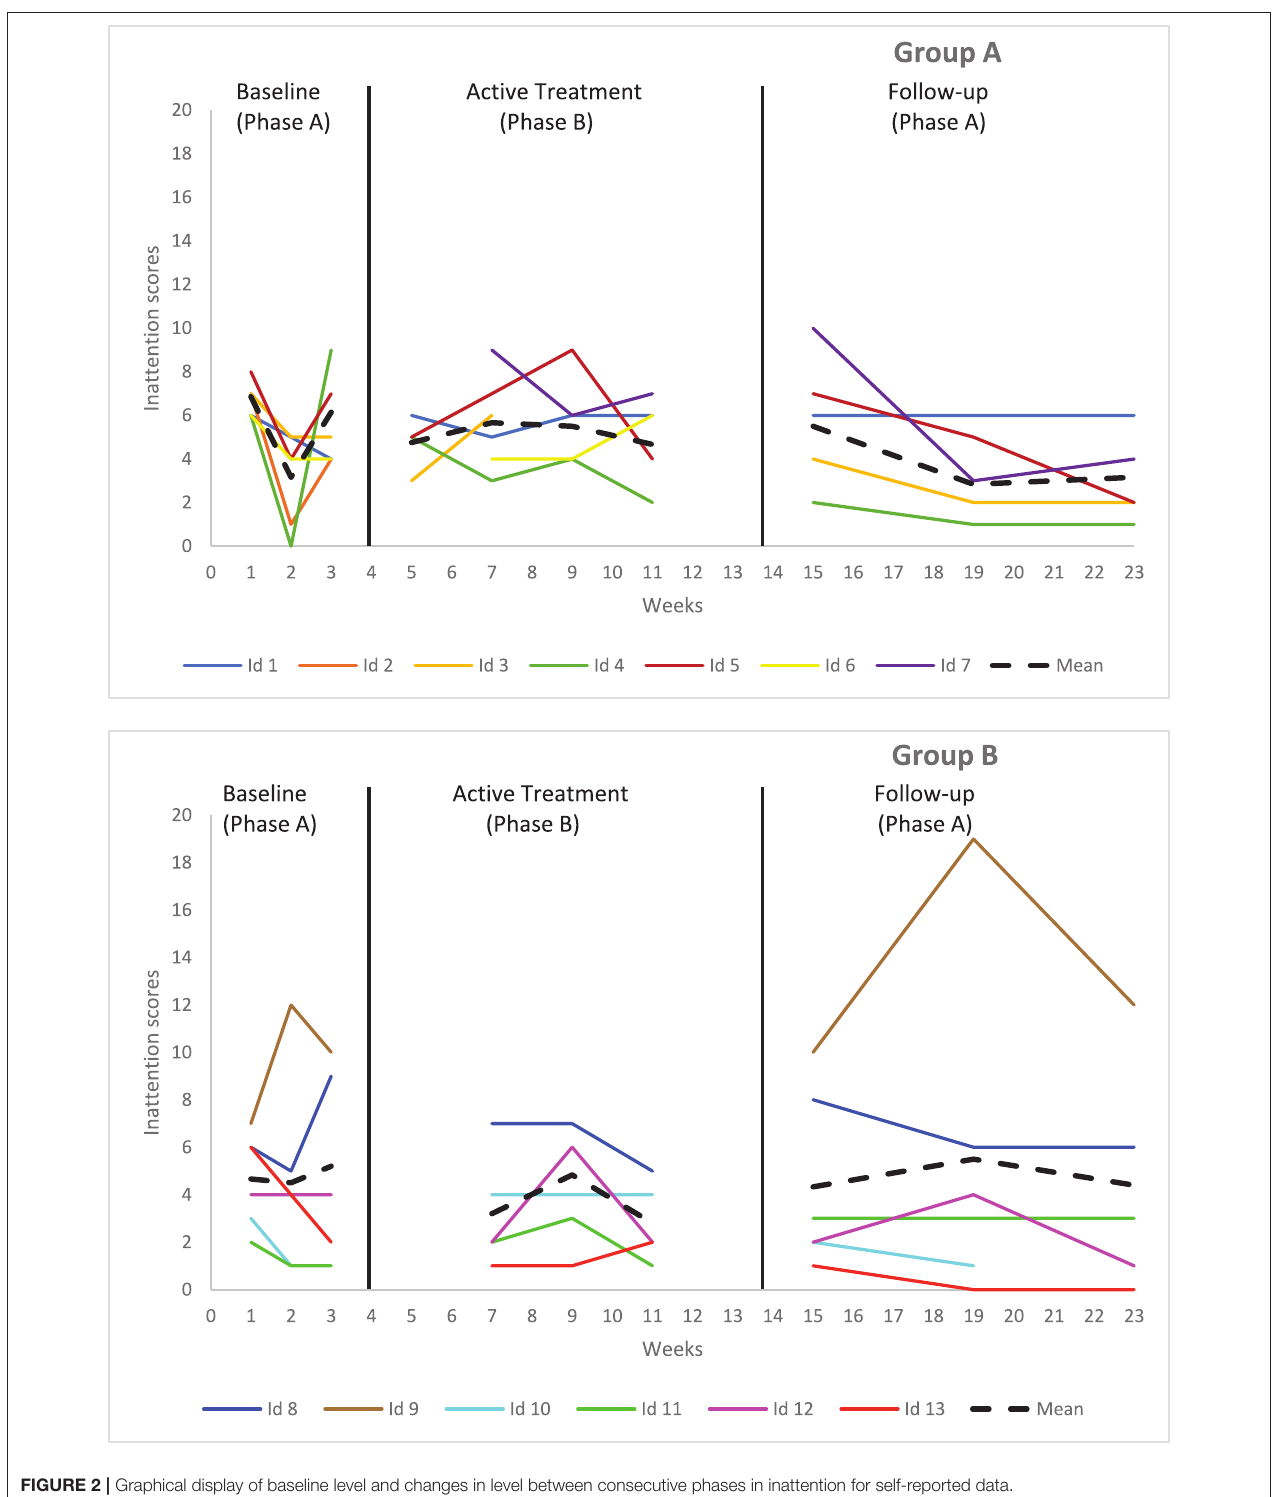
FIGURE 2 | Graphical display of baseline level and changes in level between consecutive phases in inattention for self-reported data.